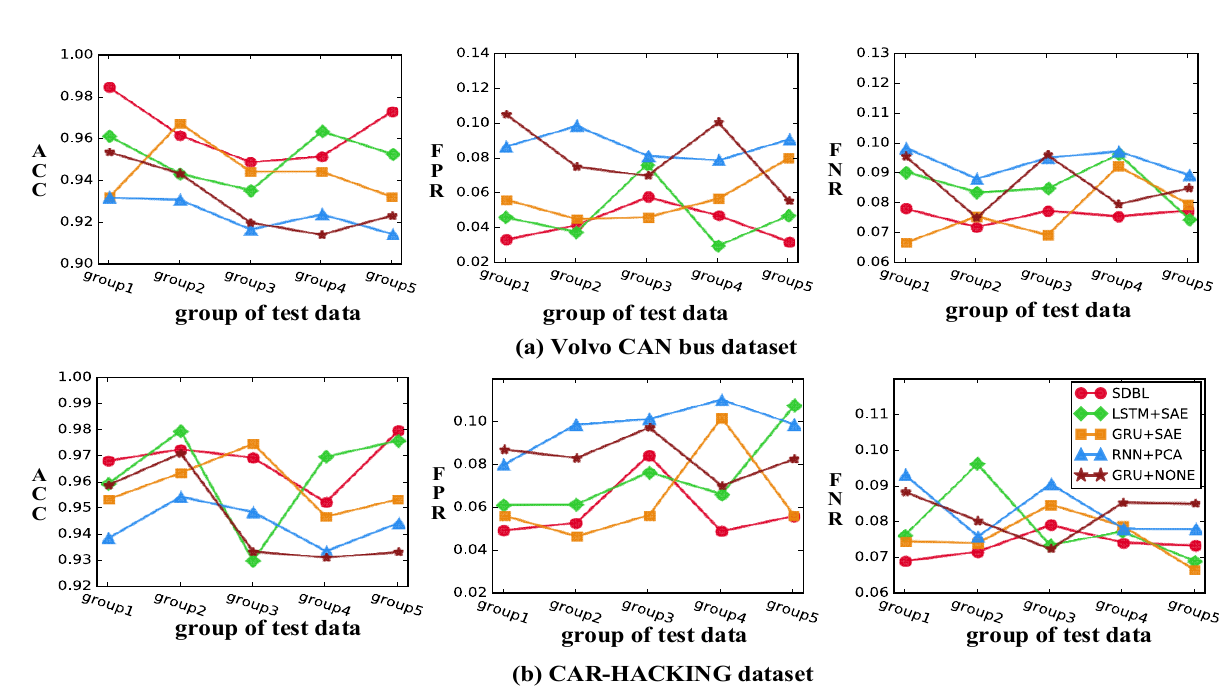
Figure 9. Performance analysis of five algorithms. ( a ) the performance comparison of five algorithms on Volvo CAN bus dataset; ( b ) the performance comparison of five algorithms CAR-HACKING dataset.